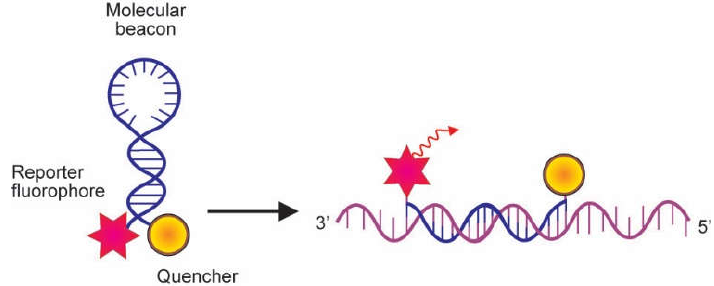
Figure 5. Mechanism of action of the molecular beacon. Molecular beacons contain covalently linked fluorescent and quenching dyes at either end of a single-stranded DNA molecule. Whilst free in solution, the probe is maintained in a hairpin conformation by complementary stem sequences at both ends of the probe, which brings the fluorescent dye and the quencher in close proximity. This causes fluorescence resonance energy transfer (FRET) to occur, which suppresses reporter fluorescence. The loop part of the molecule is complementary to the target nucleic acid molecule. In the presence of a target sequence, the loop hybridizes to the complementary target sequence throughout the annealing step, resulting in a conformational alteration that forces the reporter and quencher dyes to separate, and fluorescence is emitted (Adapted from Arya et al. [5]).